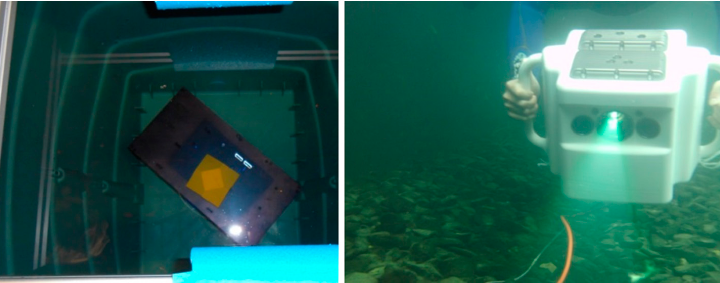
Figure 8. Frustum of pyramid in a rain barrel ( left ) and scanner in underwater use ( right ).